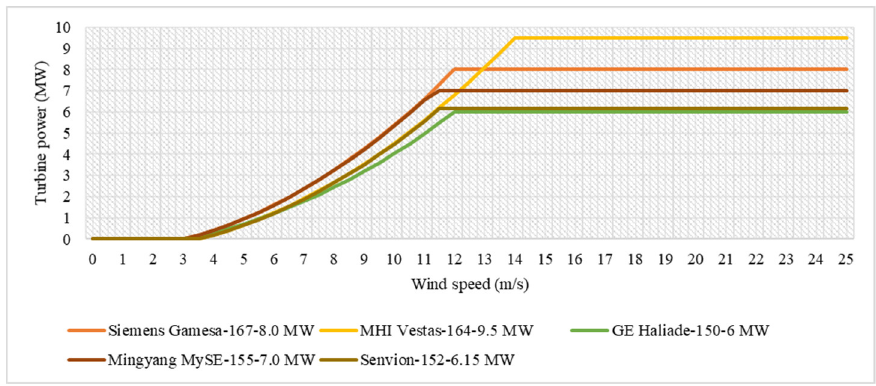
Figure 2. Power curves of the selected wind turbines.